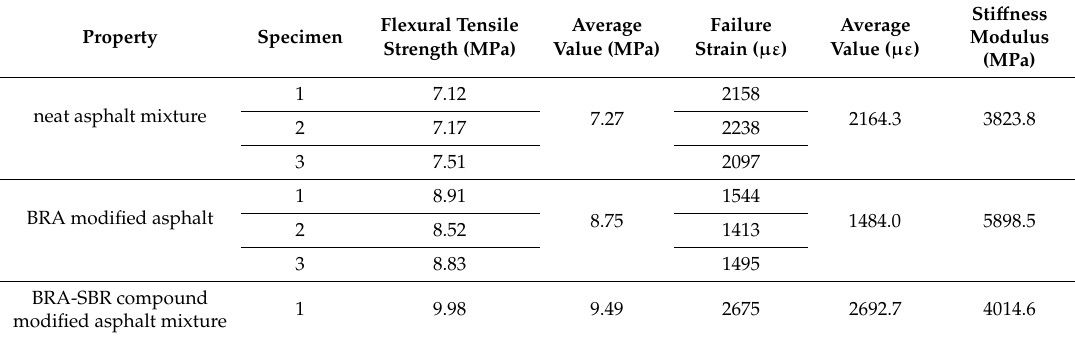
Table 22. Creep bending test results of BRA–SBR compound modified asphalt mixture.